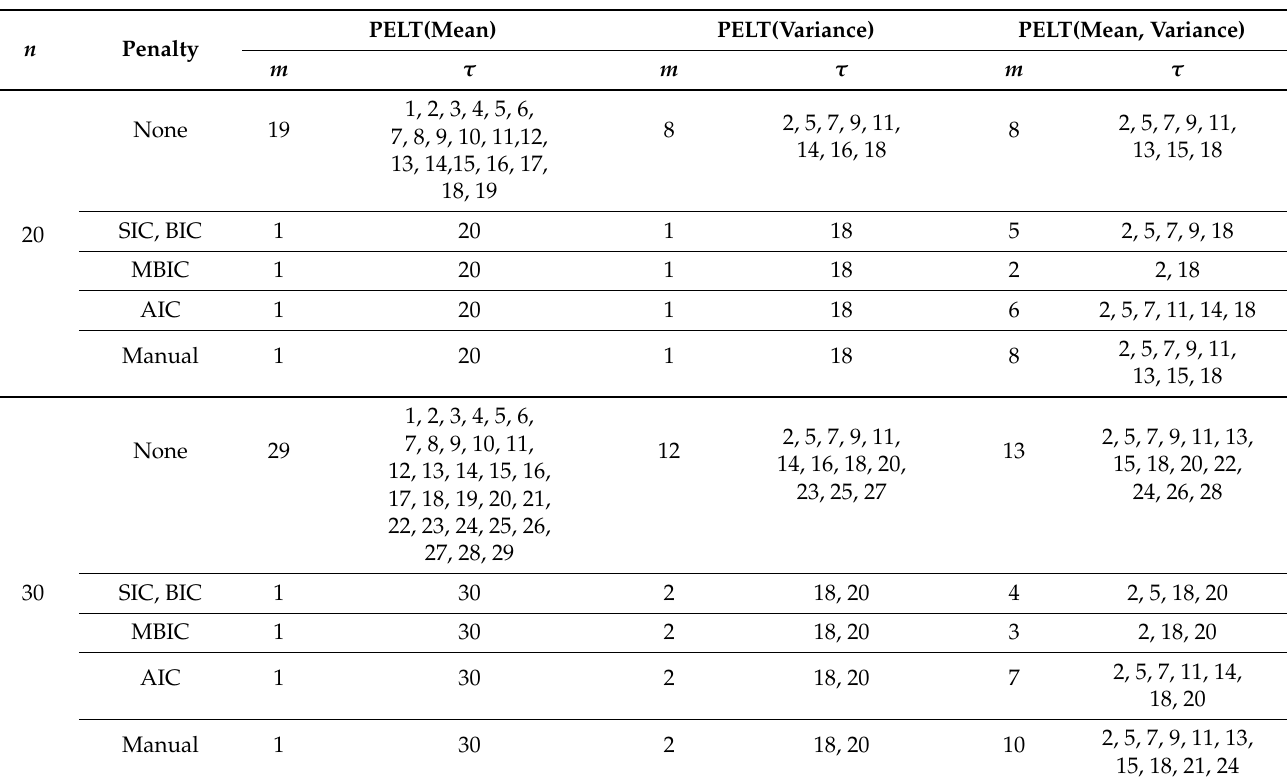
Table A1. PELT Algorithm Result for Simulated Transmissibility Rate.